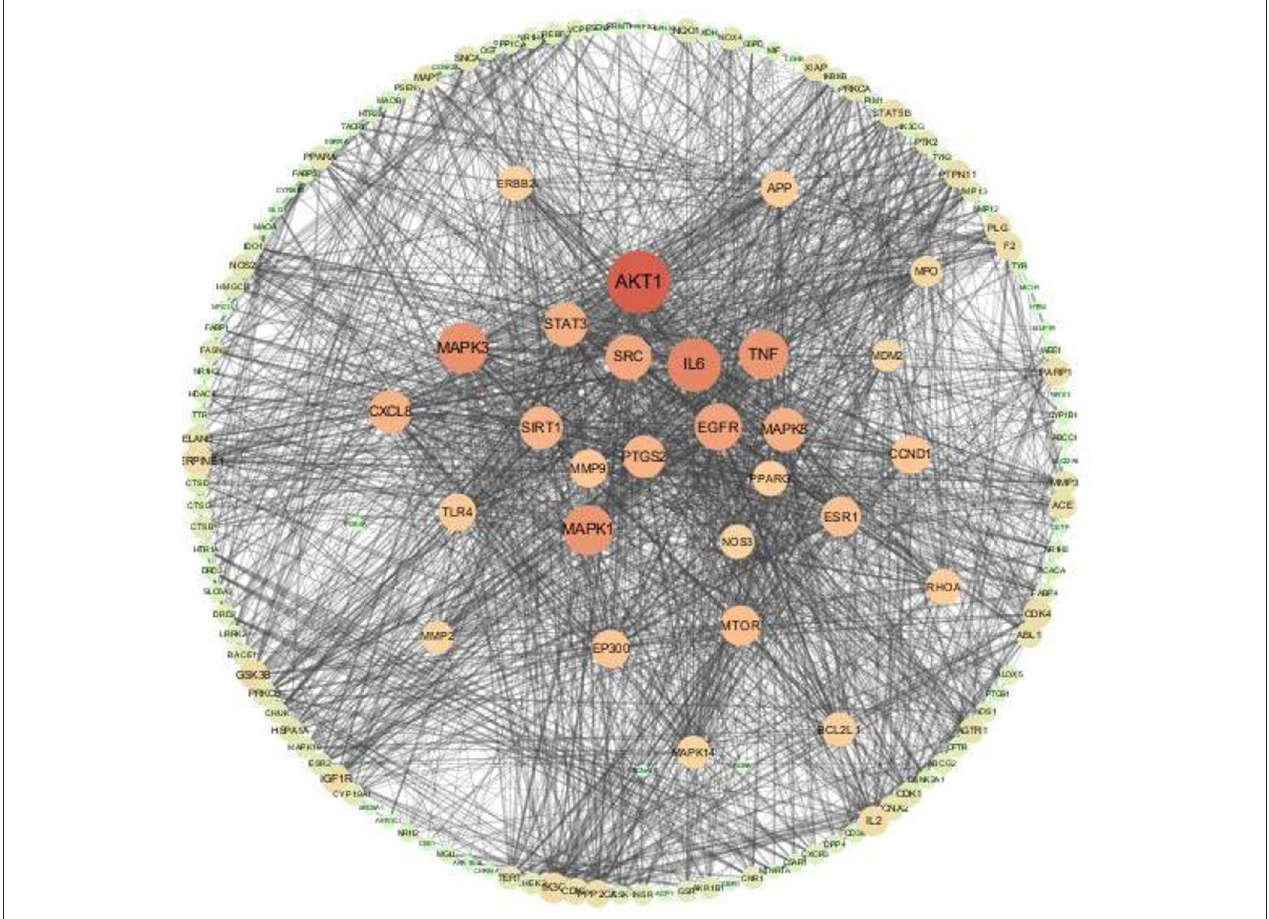
FIGURE 6 | Antioxidant targets of AS interaction network.